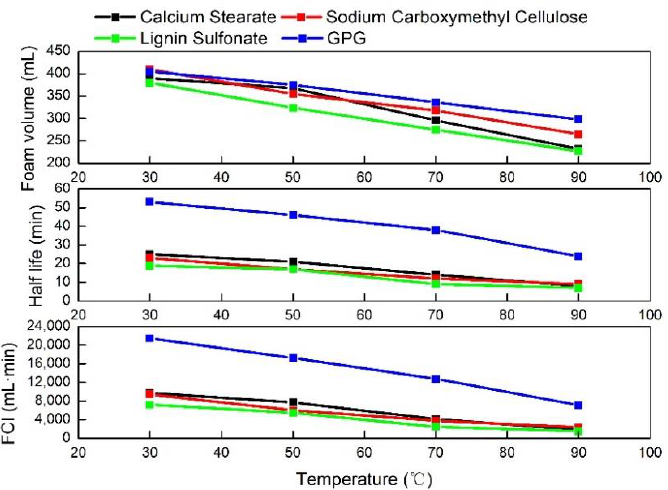
Figure 10. Effect of different temperatures on the performance of foam